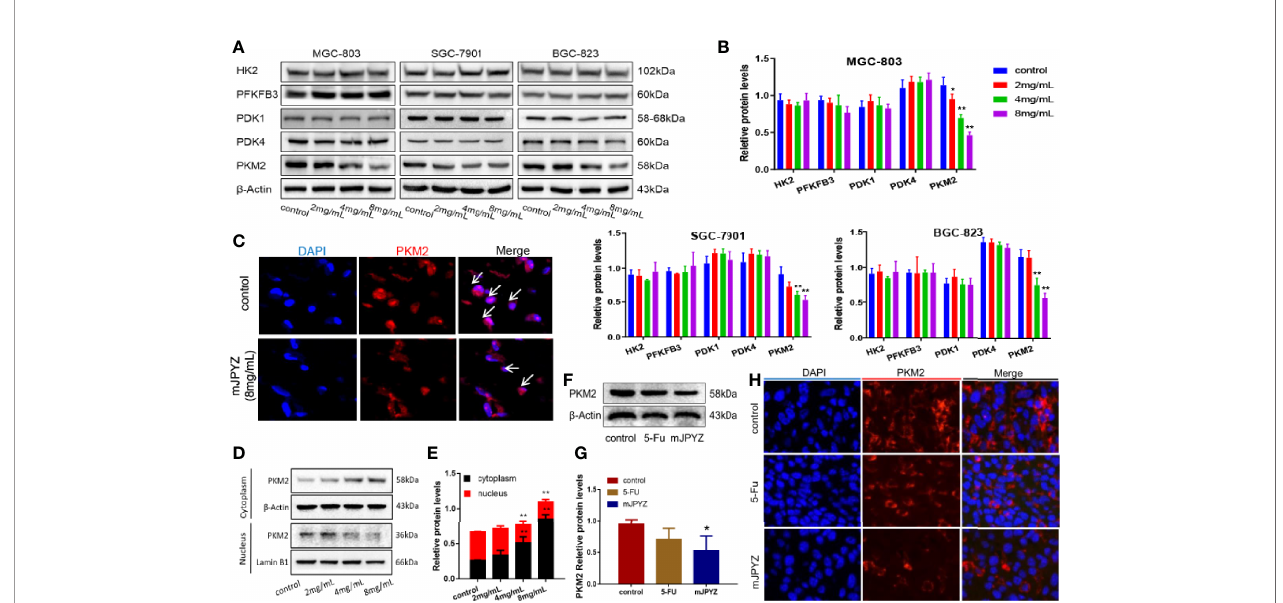
FIGURE 4 | mJPYZ effected the expression and location of PKM2 in gastric cancer. (A, B) Western blotting analysis of three rate-limiting enzymes and ATP related enzymes. mJPYZ treatment decreased the expression of PKM2 in a dose-dependent manner, while the others expression unchanged. (C) Immuno fl uorescence showed PKM2 expression was reduced after mJPYZ treatment in vitro . (D, E) mJPYZ suppressed PKM2 translocating into the nucleus, meanwhile increased in the cytoplasm. (F, G) Western blotting analysis of PKM2 expression in vivo . mJPYZ treatment decreased the expression of PKM2. (H) Immuno fl uorescence showed PKM2 expression was reduced after mJPYZ in vivo . Data are represented as mean ± SD, n=3 independent experiments. *P < 0.05, **P < 0.01 versus control group by the one-way analysis of variance (ANOVA) followed by Tukey ’ s post-hoc tests.